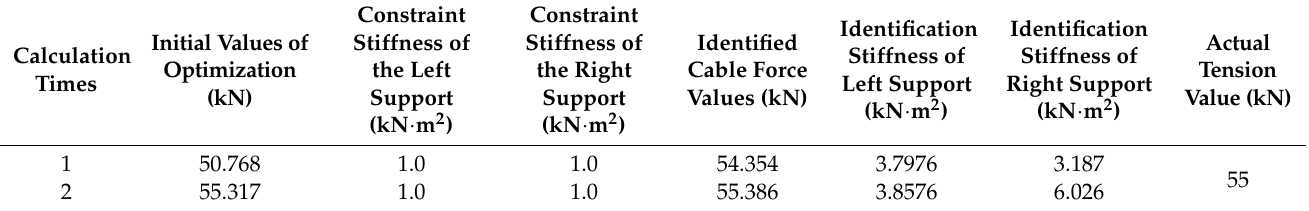
bidirectional string structure.